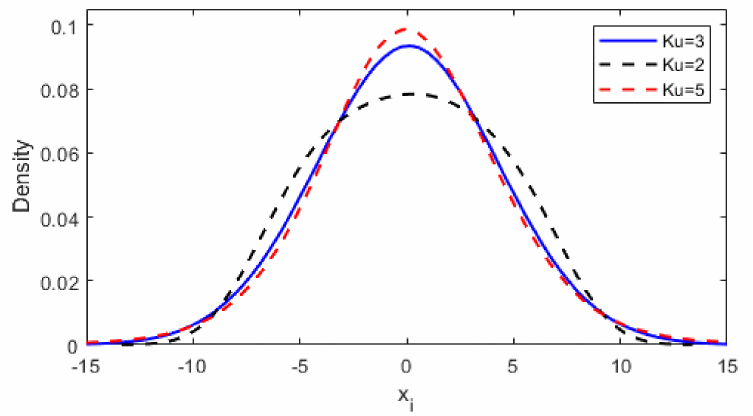
Figure 2. Change in the distribution of a random variable for different values of the kurtosis